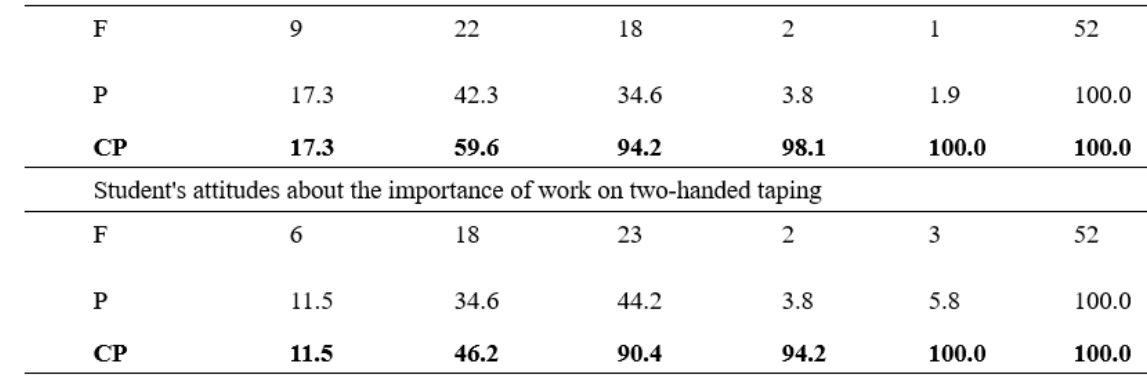
Table 14. Student’s attitudes about